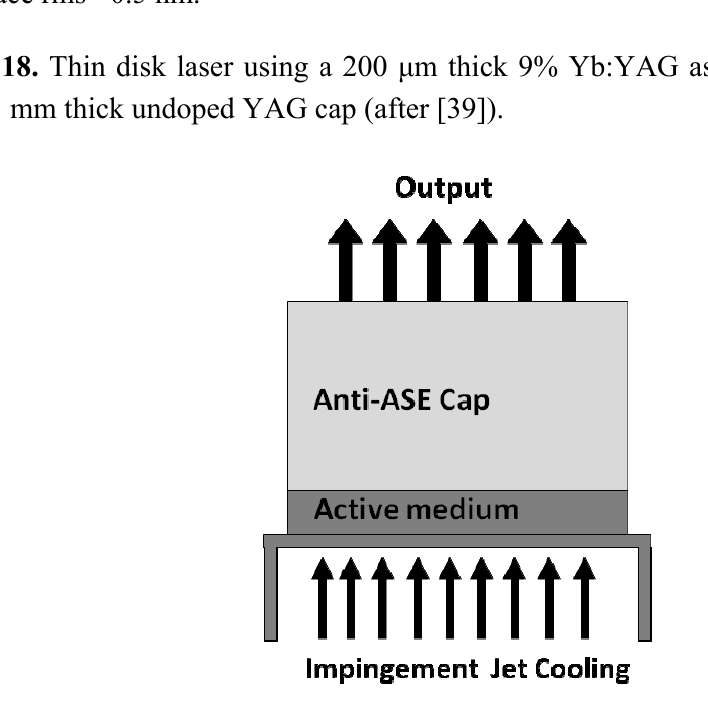
Figure 19. Different solid state laser configurations used for high power demonstrations: